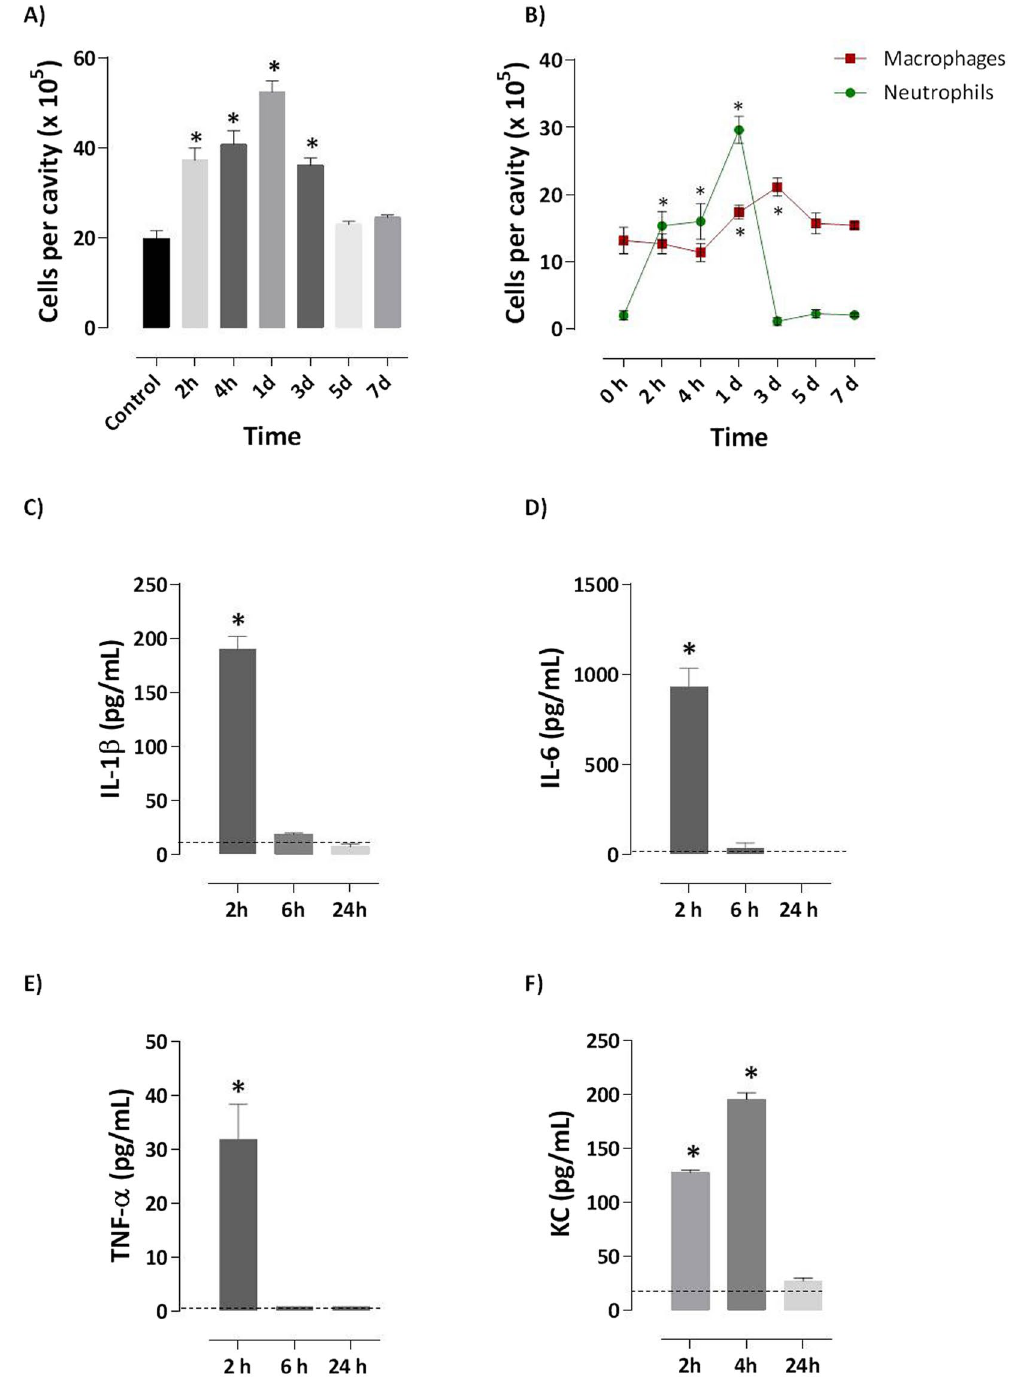
Figure 2. Stingray venom induces neutrophilia with a peak at 24 h after injection. At different time points (2 and 4 h, 1, 3, 5 and 7 days) after i.p. injection of 500 μ l of ray venom at 300 μ g/ml, Swiss mice ( n = 4–7 per group) were killed and peritoneal cavities were washed for cell suspension collection. Total ( A ) and neutrophils ( B ) were counted. Levels of IL-1 β ( C ), IL-6 ( D ), TNF- α ( E ) and KC ( F ) in exudates of peritoneal cavities of mice were analyzed by ELISA or CBA. Mice injected with only saline constituted the control-group (dotted line). Results represent mean ± SEM. Pooled results of two independent experiments. * p < 0.05 compared with the